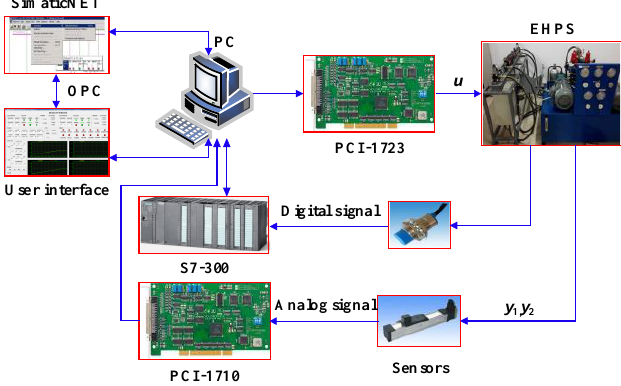
Figure 7. The experimental platform of electro-hydraulic synchronous control system.